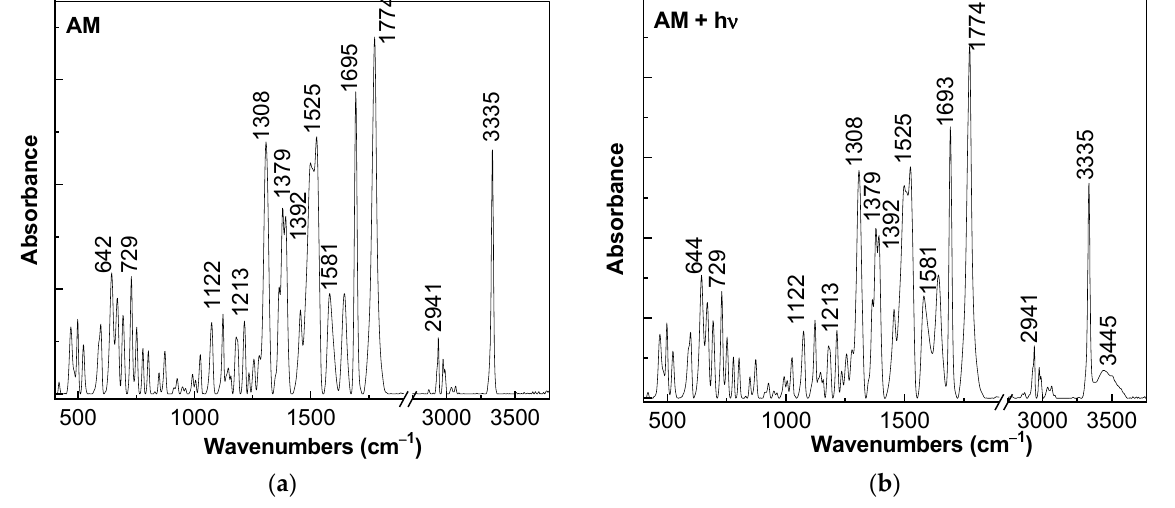
Figure 5. FTIR spectra of AM before ( a ) and after the UV exposure; time of 273 min ( b ).